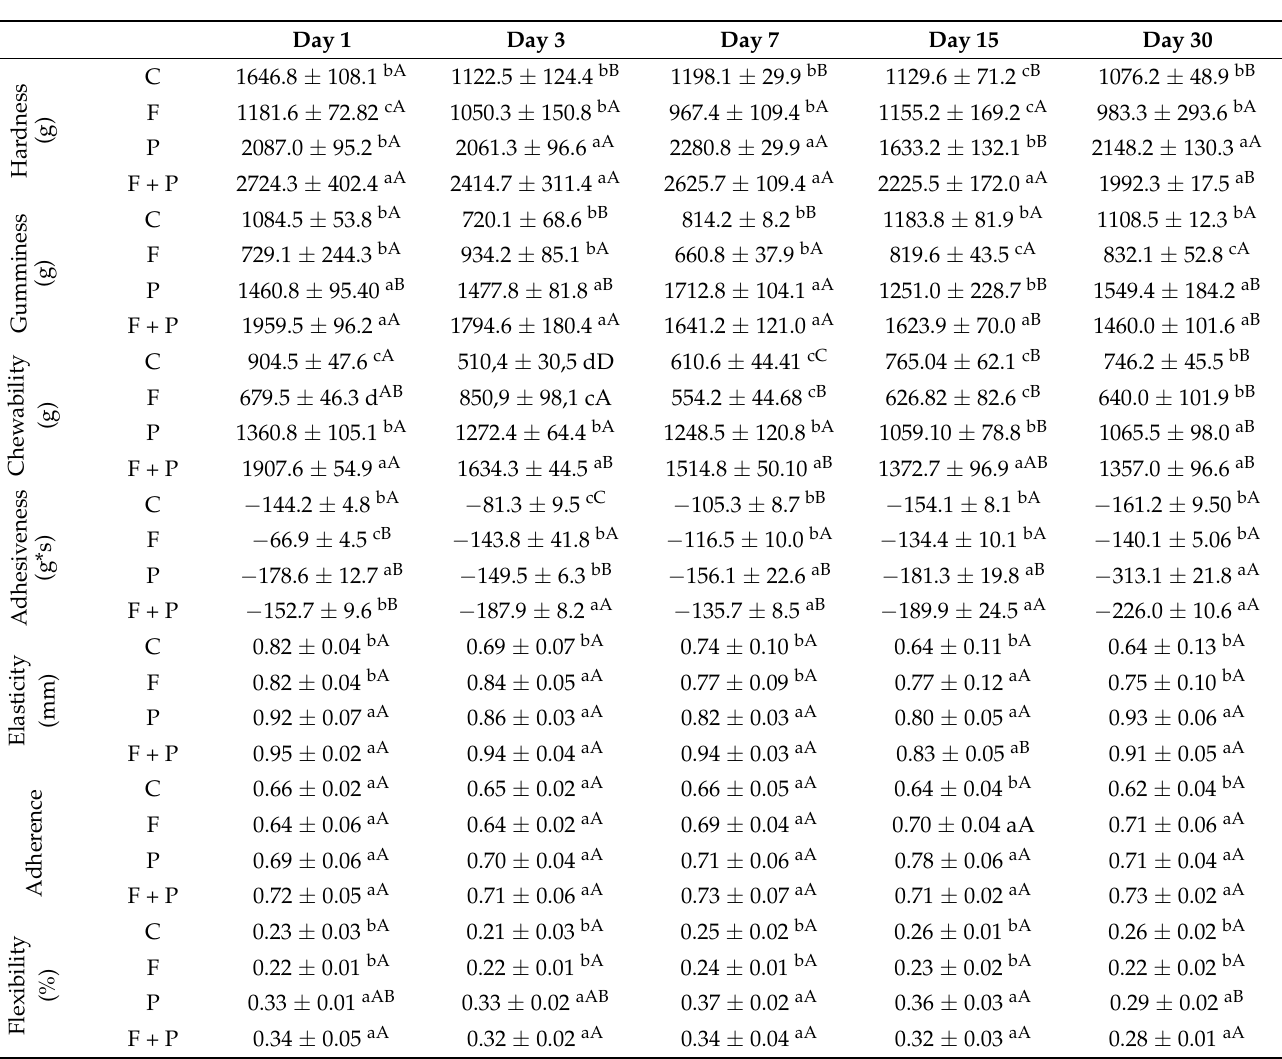
Table 3. Textural properties of fresh minced meat that was pressurized (350 MPa, 10 ◦ C, 10 min) during